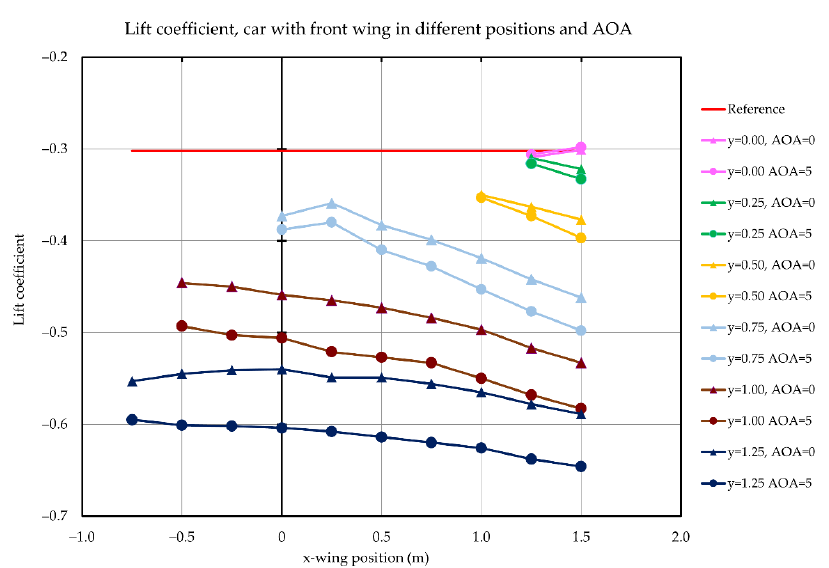
Figure 22. Changes in lift force acting on the vehicle as a function of the wing position relative to the body and depending on the angle of attack (AOA). The use of the front wing, except for some positions, causes an increase in the negative lift force, i.e., an increase in aerodynamic downforce.